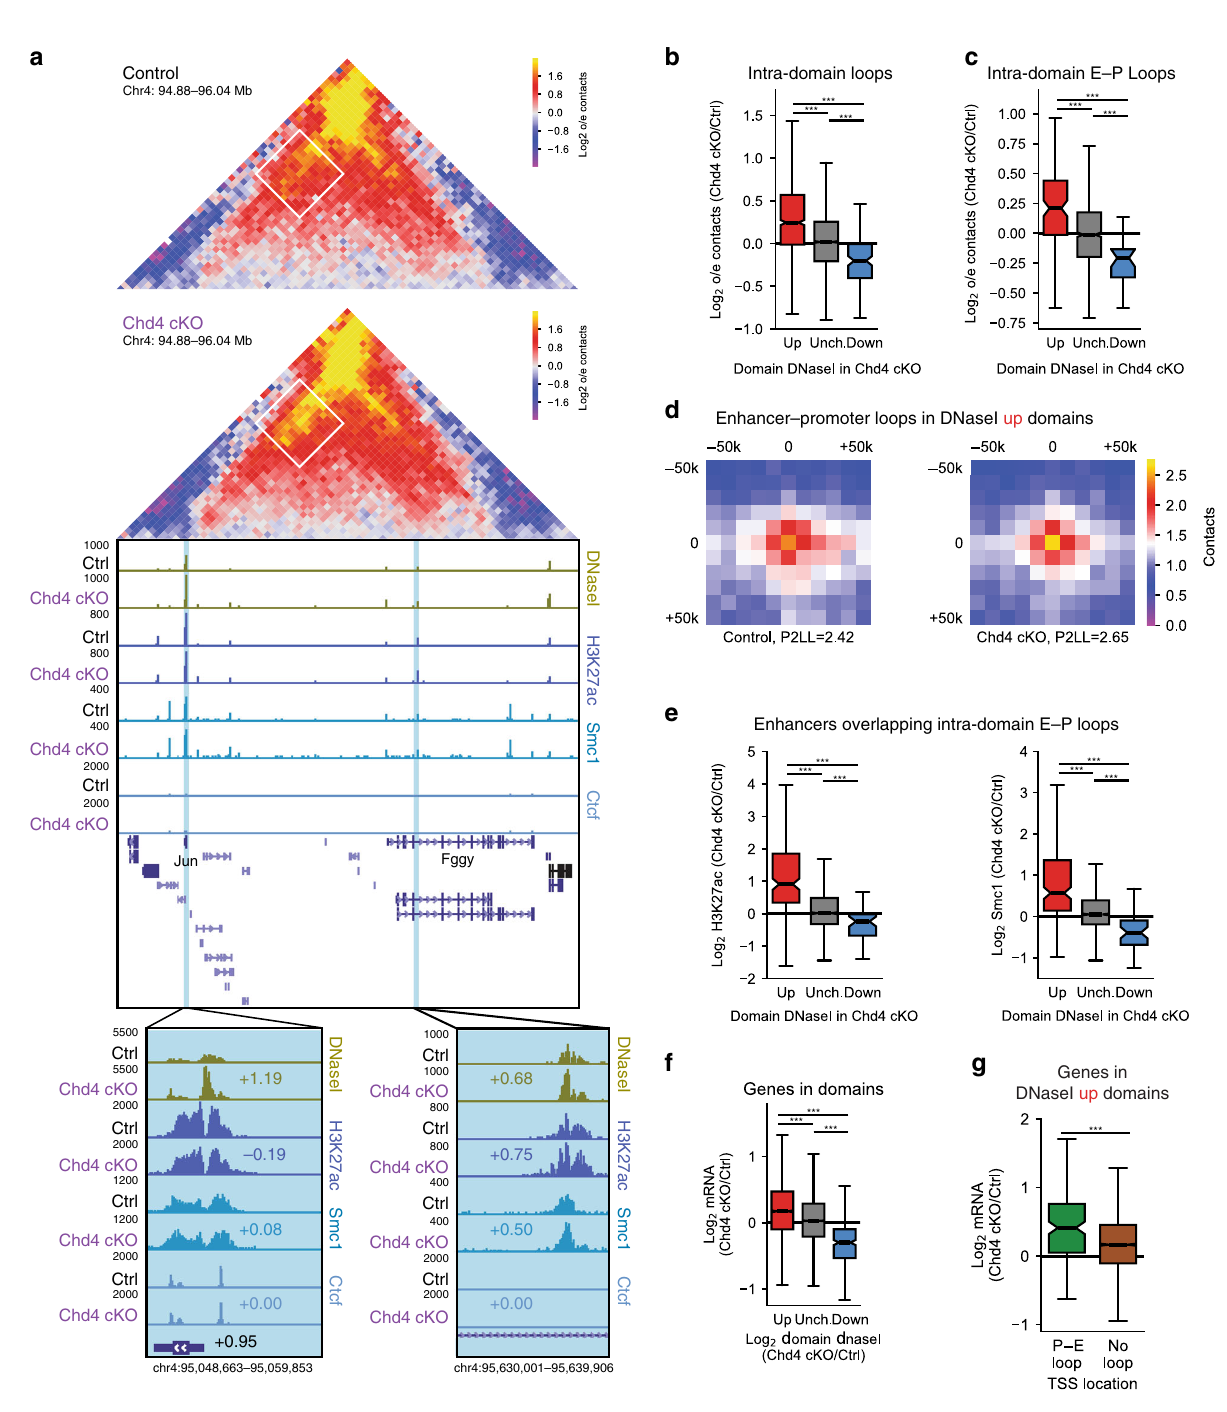
Fig. 3 Chd4 regulates loop domain boundary loop strength. a (Top) Hi-C contact matrix of a loop domain on chromosome 10 and the fl anking region, with a loop domain boundary loop highlighted by a white box. (Bottom) Genome-browser snapshot of the region corresponding to the Hi-C contact matrix displaying the ChIP-seq pro fi les of H3K27ac, Smc1, and Ctcf as well as DNaseI-seq from the control and Chd4 cKO cerebellum. Blue denotes the the loop anchors and regions of the insets. Numbers indicate the Log2 change in signal in the Chd4 cKO cerebellum. b Change in Hi-C contacts at loop domain boundary loops among domains with increased ( n = 613), unchanged ( n = 2299), or decreased ( n = 105) accessibility in the Chd4 cKO. c Change in Smc1 occupancy at non-promoter DHS underlying loop domain boundary loops among domains with increased ( n = 1343), unchanged ( n = 5336), or decreased ( n = 241) accessibility. P -values for all comparisons in this fi gure were calculated by the two-sided Kruskal – Wallis H-test for independent samples with Dunn ’ s post hoc T-test and corrected for multiple comparisons by the Bonferroni – Hochberg procedure. ***p < 0.001